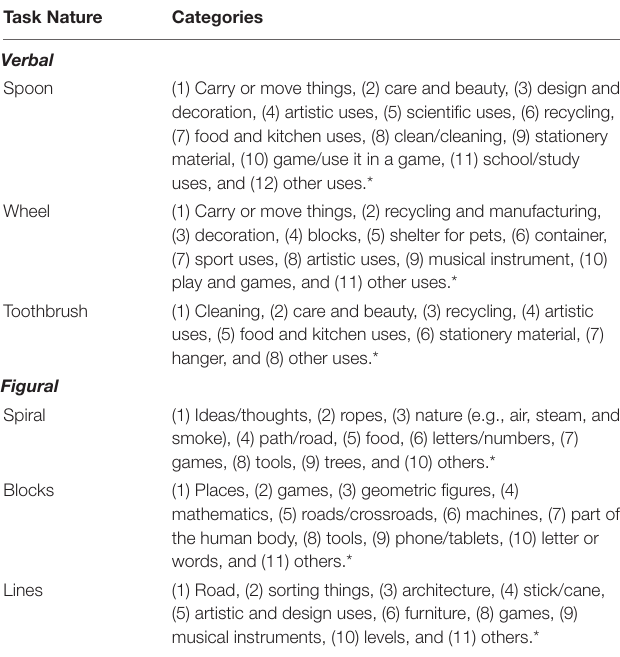
TABLE 2 | Flexibility categories for verbal and figural tests.